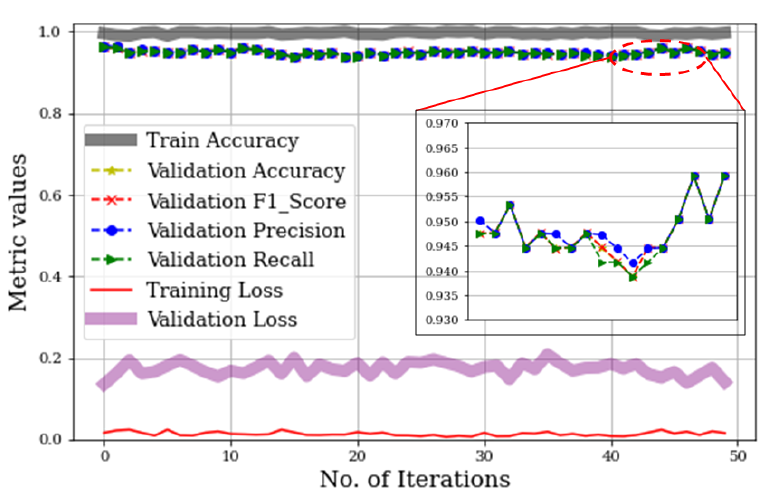
Figure 6. Model training/validation history showing accuracy, loss, precision, recall, and